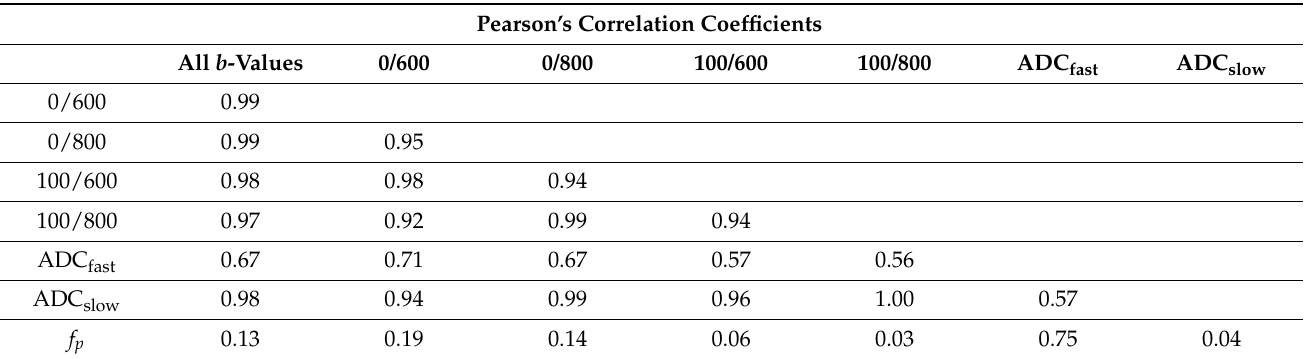
Table 2. Correlations between pre-treatment tumor ADC and f p metrics using different b -value combinations. Pearson’s Correlation Coefficients